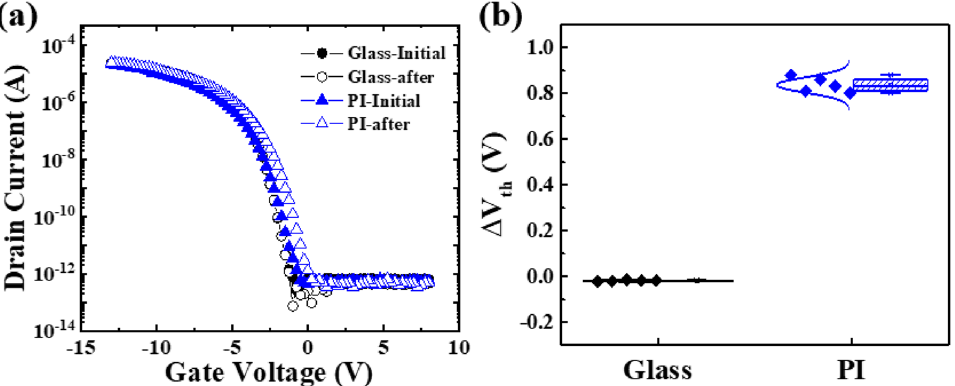
Figure 1. ( a ) I D –V G plot of P-type LTPS TFTs before and after the BTS. Note that the P-type LTPS TFTs were fabricated on glass (black filled circle) and PI (blue filled triangle) substrates and ( b ) ΔV th before/after BTS of TFTs fabricated on glass and PI substrates.